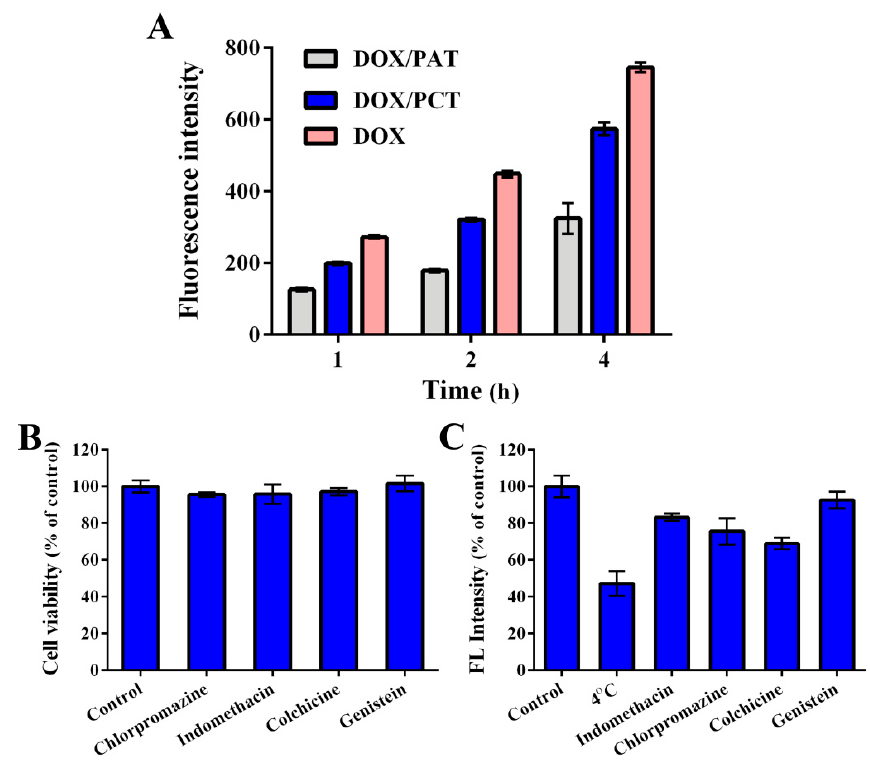
Figure 6. ( A ) The uptake of free DOX and DOX-loaded micelles at 1, 2, and 4 h in B16 cells. ( B ) ( B ) Cytotoxicity of different endocytosis inhibitors and ( C ) the effects on the uptake of DOX/PCT of different endocytosis inhibitors (mean ± SD ( n =